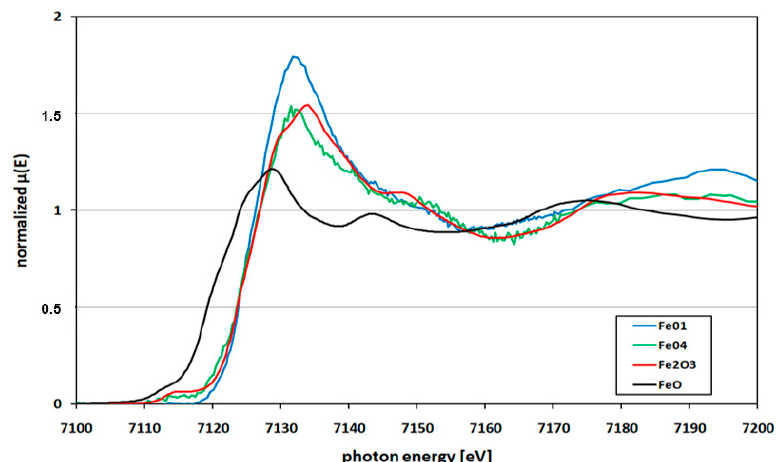
Figure 5. Fe K-edge XANES spectra of kunzite from Nuristan, Afghanistan, (Fe-01, Fe-04 represent kunzite samples) versus FeO and Fe 2 O 3 standards.